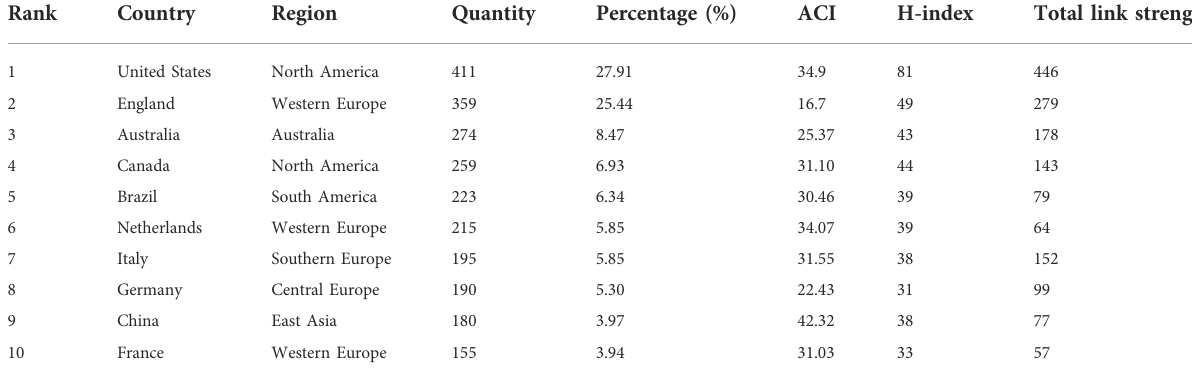
ACI, average citations per item.